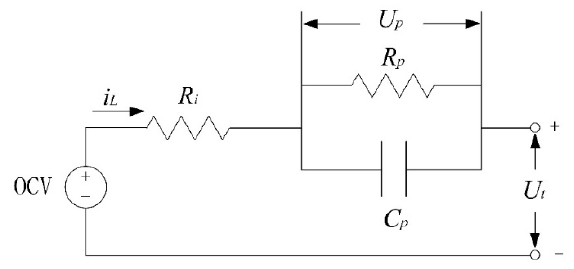
Figure 1. Thevenin model.